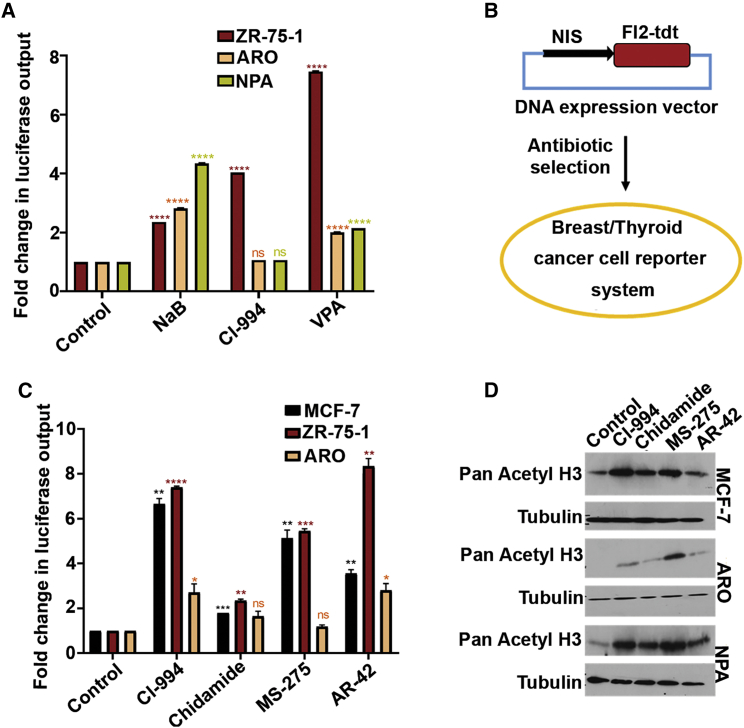
Benzamide Class of HDACi Enhances NIS Gene Expression in BC Cells(A) Graph showing fold difference in normalized NIS promoter driven luciferase reporter activity in non-benzamide (NaB, VPA) and benzamide (CI-994) drug-treated ZR-75-1, ARO, and NPA cells with respect to the untreated control. (B) Schematic explaining establishment procedure of pNIS-FL2.Turbo-overexpressing stable cell models using breast (MCF-7 and ZR-75-1) and TC (ARO) cell lines. (C) Bar graph showing fold differences of luciferase reporter activity in various benzamide drug-treated MCF-7, ZR-75-1, and ARO cells overexpressing pNIS-Fl2.Turbo construct. Error bar represents SEM; significance determined by t test. ∗∗p ≤ 0.01; ∗∗∗p ≤ 0.001. The color of the asterisk (∗) indicates the significance with their respective control. (D) Semiquantitative western blot showing increased pan acetylation of histone H3 in MCF-7, ARO, and NPA cells after treatment with various bHDACi drugs. Tubulin is used as loading control.